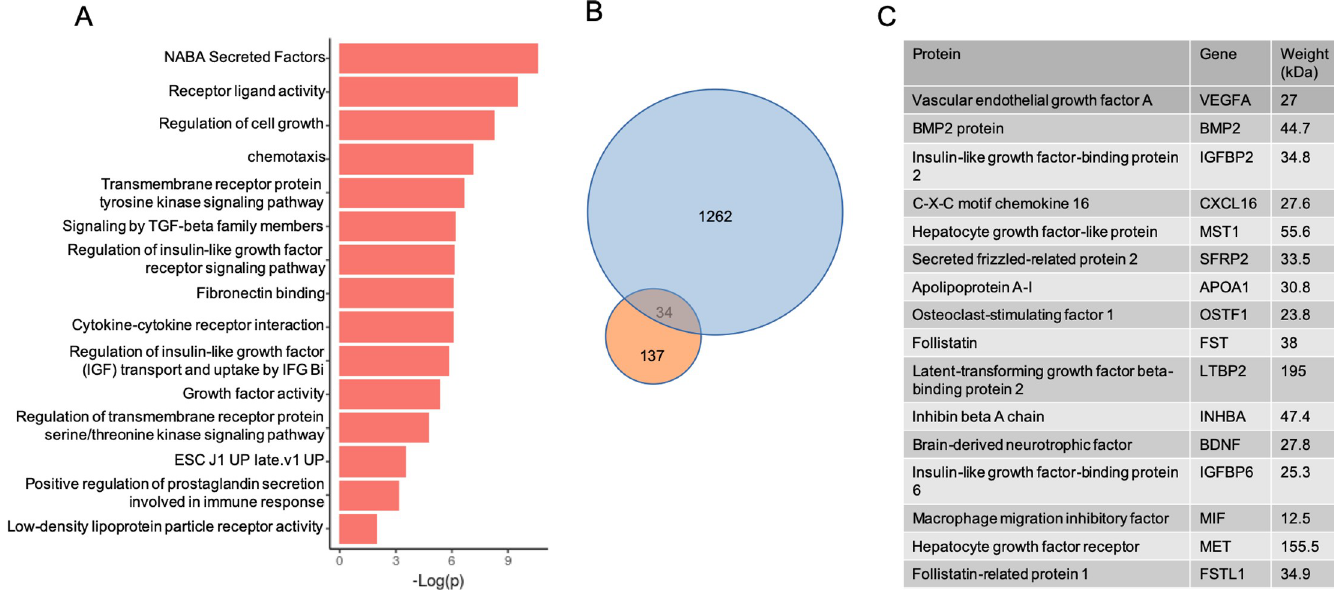
Fig 5. Conditioned media pathway analysis of the extracellular signaling molecules. A) Pathway analysis of signaling molecules upregulated in the PH-CM. B) Comparison of the upregulated genes in the PH Cfib transcriptome (blue circle) with significantly enhanced proteins in the PH-CM (orange circle). Of the 137 secreted proteins found enriched in the conditioned media, the transcripts of 34 of these were also found increased in the transcriptome of the PH fibroblasts. C) Representative list of 16 of the 34 proteins identified as enriched in the PH conditioned media with known signaling properties that were also found upregulated in the PH Cfib transcriptome. The human orthologues are displayed in the table and were then used for pathway